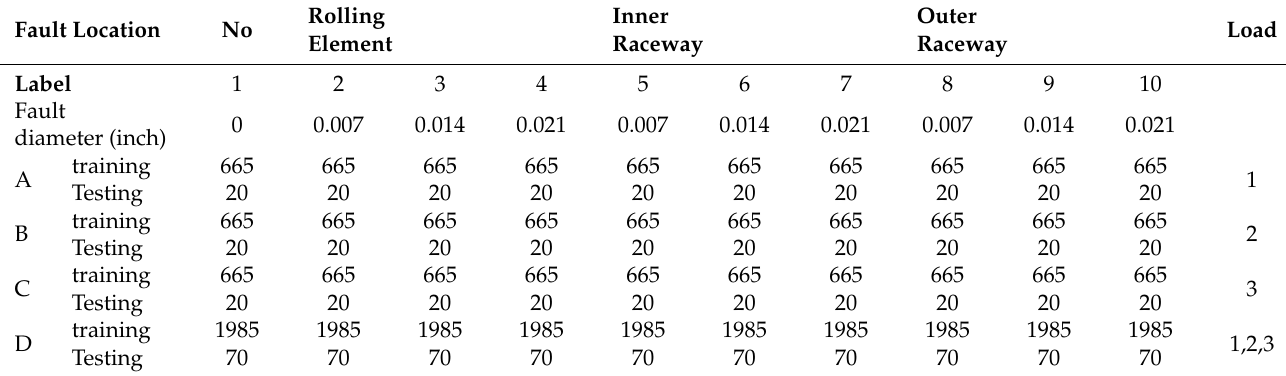
Table 1. Table 1. Description of experimental datasets.